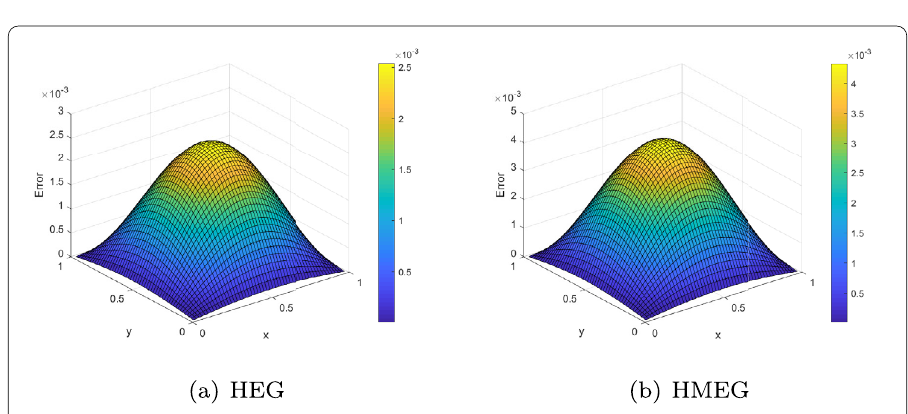
Figure 10 The graphical error representation of the HEG and HMEG methods at α = 0.7, h = 1/54 for Example